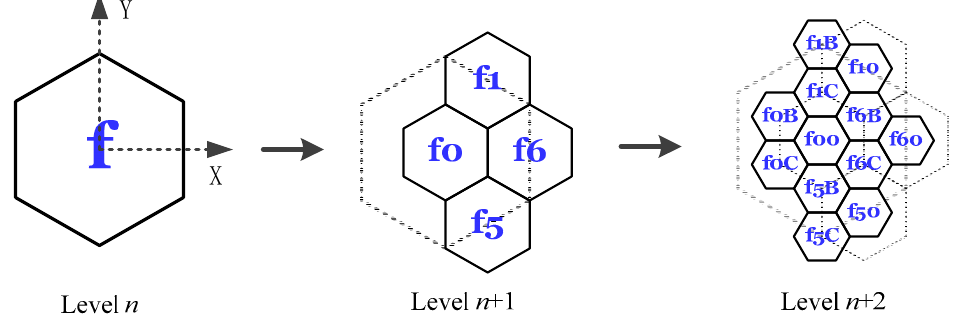
Figure 8. Diagram of the proposed hierarchy-based indexing method with aperture sequence 43 from level n to level n + 2. The type of child cells for aperture 4 is from Figure 6c, and that for aperture 3 is from Figure 6b (source—own study).